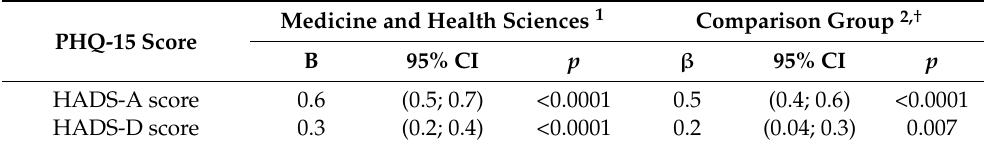
Table 3. Linear regression analyses with somatic symptoms (PHQ-15) as dependent variables.